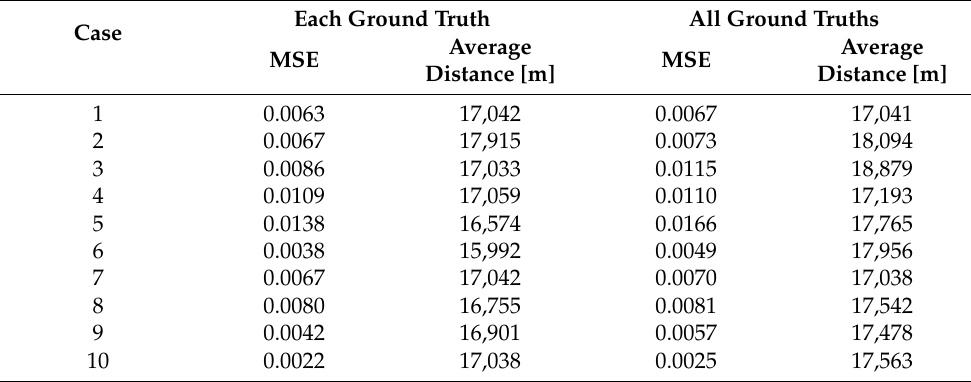
Table 4. Comparison of the MSE and the average